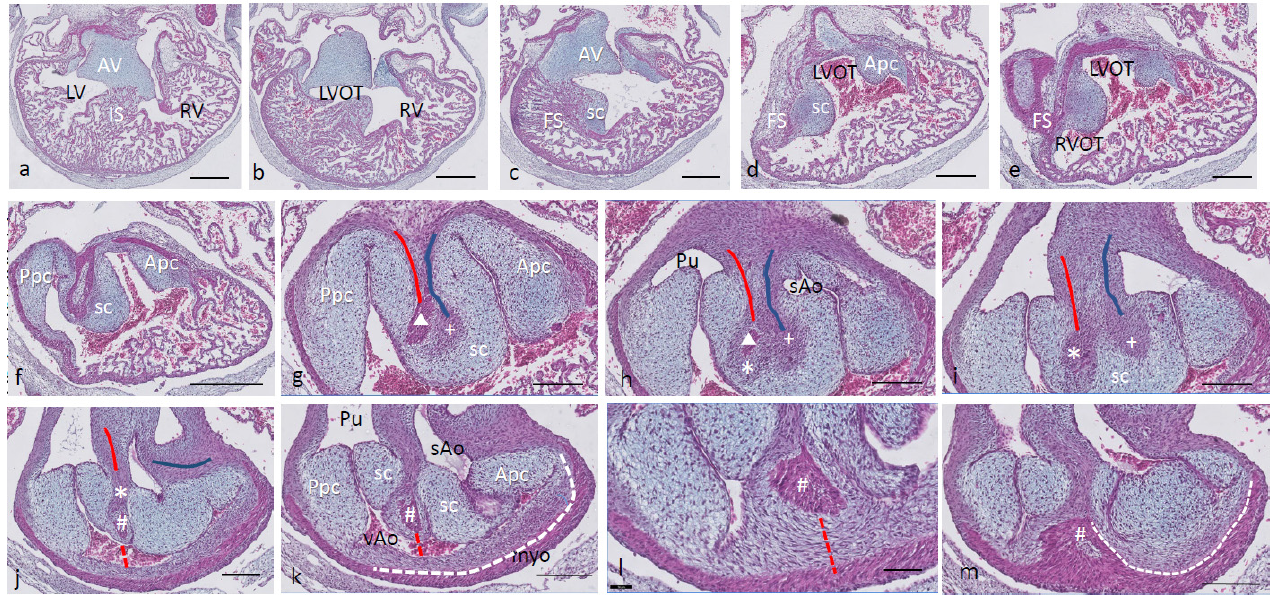
Figure 2. Ferguson stage 19. HE Alcian blue-stained serially sectioned embryo. Figure ( a – m ) from AV canal to OFT. Figure ( a ), ventricular myocardial inlet septum attached to the central AV cushions between the left and right ventricles. The myocardium is spongy but for the thin outer compact layer. Figure ( b ), more ventrally, the interventricular communication is visible, while the left ventricular outflow tract becomes apparent. Figure ( c ), muscular folding septum appears as continuation of the inlet septum. The septal OFT cushion is located at the tip of the folding septum. Figure ( d ), septal cushion with Alcian blue-stained condensed mesenchyme. The aortic parietal cushion appears on the other side of the LVOT. Figure ( e ), the septal cushion is located between both outflow tracts, while the folding septum has shifted to the right side. Figure ( f ), in the RVOT the pulmonary parietal cushion is present, and the folding septum including the septal cushion takes up a dorsal position. Figure ( g ), the most cranial remnant of the muscular folding septum is indicated ( ∆ ). The adjacent condensed mesenchyme (+) belonging to the interaortic septum has appeared in the septal cushion. Figure ( h ), a second element of condensed mesenchyme (*) appears ventral to the disappearing myocardium ( ∆ ). Figure ( i ), two streams of condensed mesenchyme as part of the aorto-pulmonary septum (*) and the interaortic septum (+) separate the septal cushion into three subcushions. Figure ( j ), more distally, only the AP septum continues and receives the myocardium (#) from the ventral wall indicated by the red dotted line. Figure ( k ), the condensed mesenchyme of the AP septum is not present anymore, but the myocardial component has enlarged (#). The pulmonary trunk, the visceral aorta and the systemic aorta are indicated, as are the endocardial cushion components. Only the visceral aorta is still encased in the myocardium, but note that the arterial wall of the visceral aorta continues within the myocardial tube (dashed line). Figure ( l ), the visceral and systemic aortas are separated at this level by the AP septum (red line). Figure ( m ), here, the AP septum is myocardialized (#). Key to the symbols # ventral myocardium, part of AP septum; * (presumably) left-sided neural crest cells, part of AP septum; + (presumably) right-sided neural crest, part of IA septum; ∆ dorsal myocardium, part of AP septum. Magnification Figure ( a – f ), bar 500 µ m; ( g – m ), bar 200 µ m; ( g – m ), 200 µ m; ( l ), 100 µ